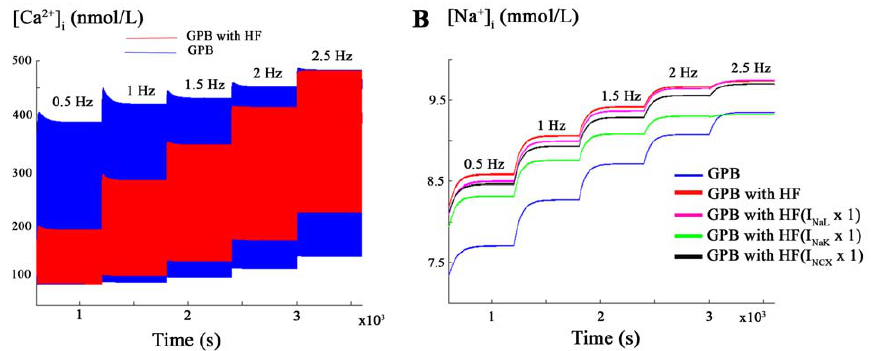
Figure 3. [Ca 2 + ] i and [Na + ] i changes with increasing frequency in HF. Influence of the stimulation rate on [Ca + 2 ] i (panel A) and [Na + ] i in nmol/L (panel B) determined using the staircase protocol. The simulations were performed using the modified GPB model with I NaL incorporated in normal conditions (blue) and the modified GPB model incorporating HF conditions (red). In panel B, conditions of HF without I NaL , I NaK or I NCX remodeling are also shown.